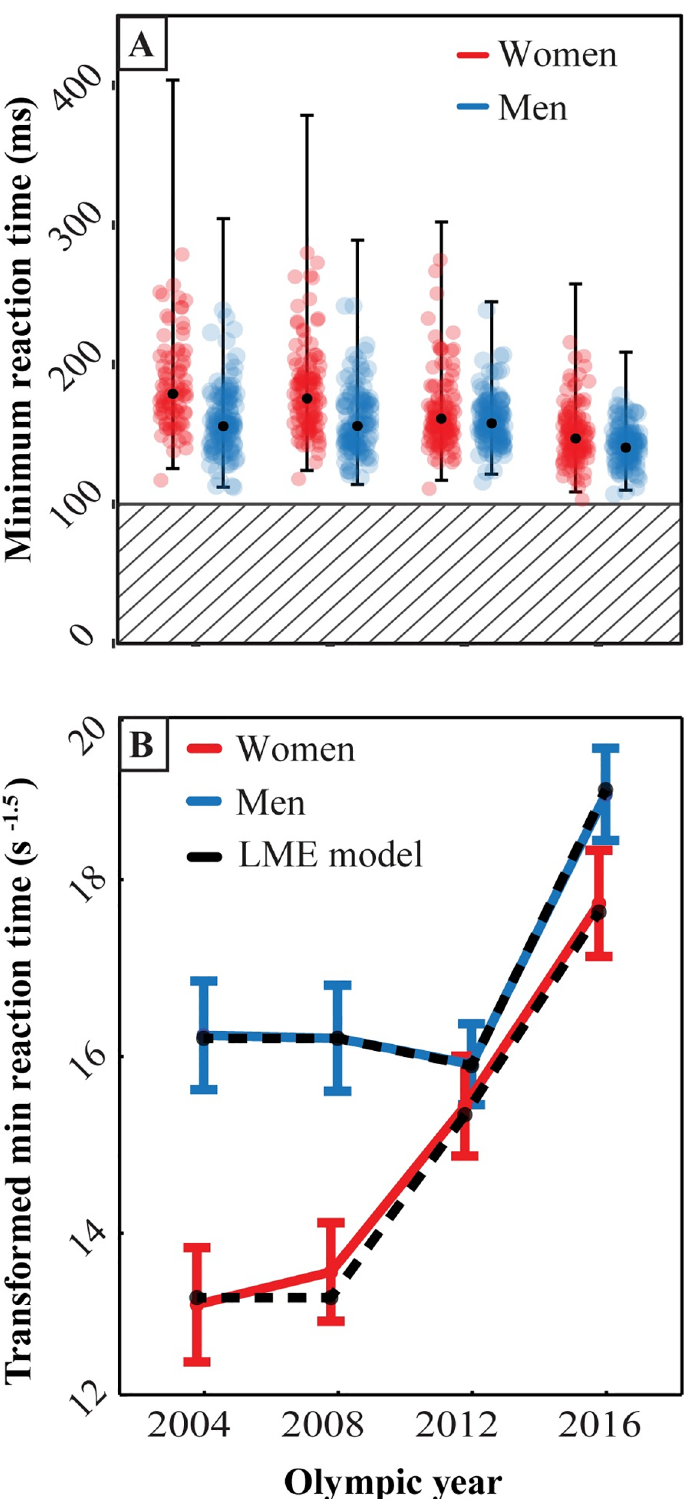
Fig 1. Sprinter minimum reaction times by sex and year in the 2004–2016 Olympics. (A) Scatter plot of reaction times by sex and year. The solid black circles and bars represent the mean and ±3SD reaction times after back- transformation. The hatched area designates reaction times deemed by IAAF rule to be a false start. The number of